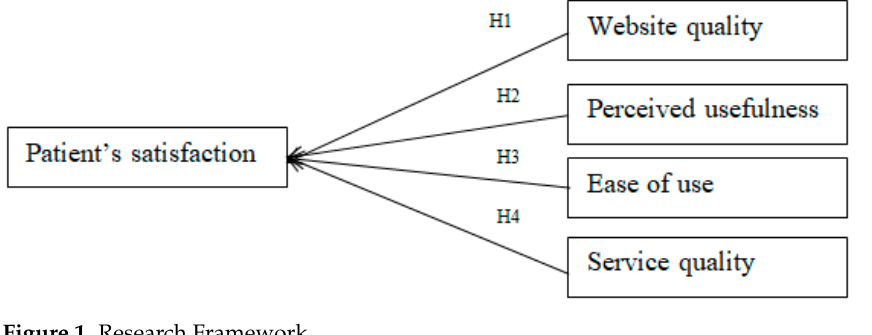
Figure 1. Research